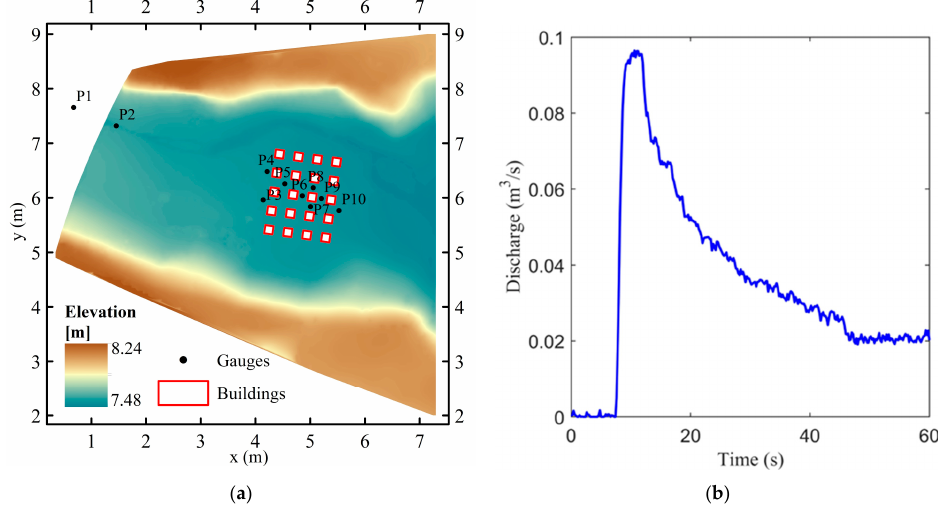
Figure 12. Flash fl ood in an urban area: ( a ) layout of the physical model; ( b ) in fl ow hydrograph. Figure 12. Flash flood in an urban area: ( a ) layout of the physical model; ( b ) inflow